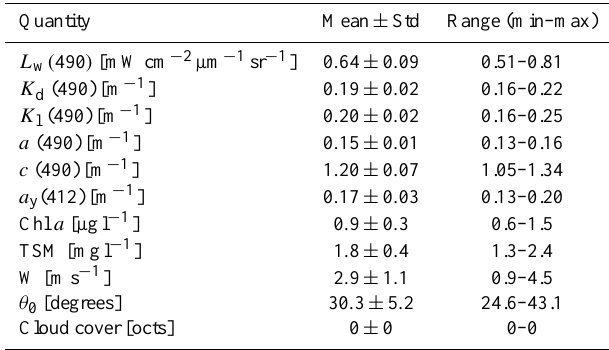
Table 9. Values of major quantities characterizing the measurement conditions during ARC activities at the